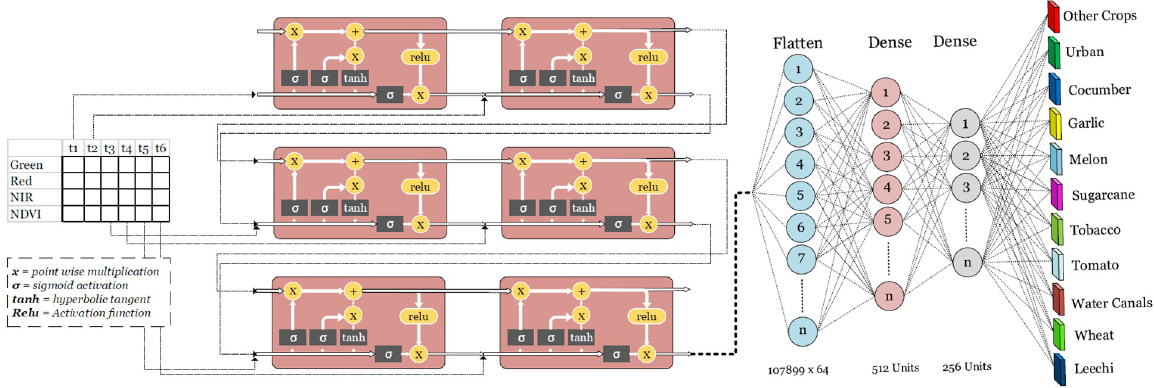
Fig 6. Long short term memory deep neural